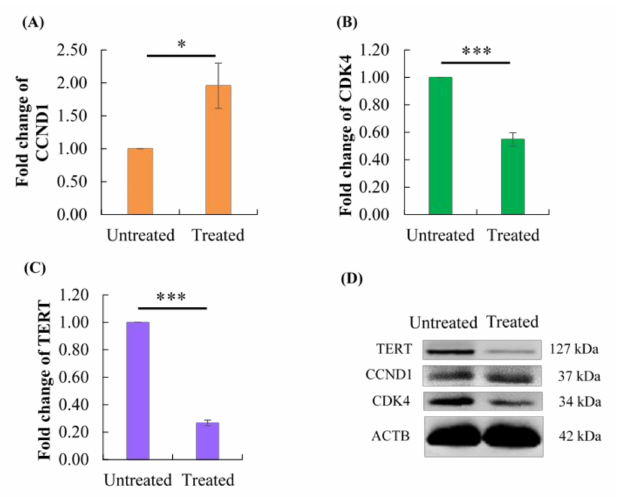
Figure 7. Effect of 10.54 µ g/mL berberine-treated HCT 116 at 48 h on ( A ) CCND1, ( B ) CDK4, and ( C ) TERT protein levels. Changes in CCND1, CDK4, and TERT protein levels are expressed as fold change in CCND1, CDK4, and TERT signal intensities, respectively, normalized to ACTB relative to untreated HCT 116 at 48 h. ( D ) Representative Western blot images of TERT, CCND1, CDK4, and ACTB. Values are mean ± standard error of triplicate. Mean with * (single asterisk) or *** (triple asterisks) differ significantly at p < 0.05 or p < 0.001,